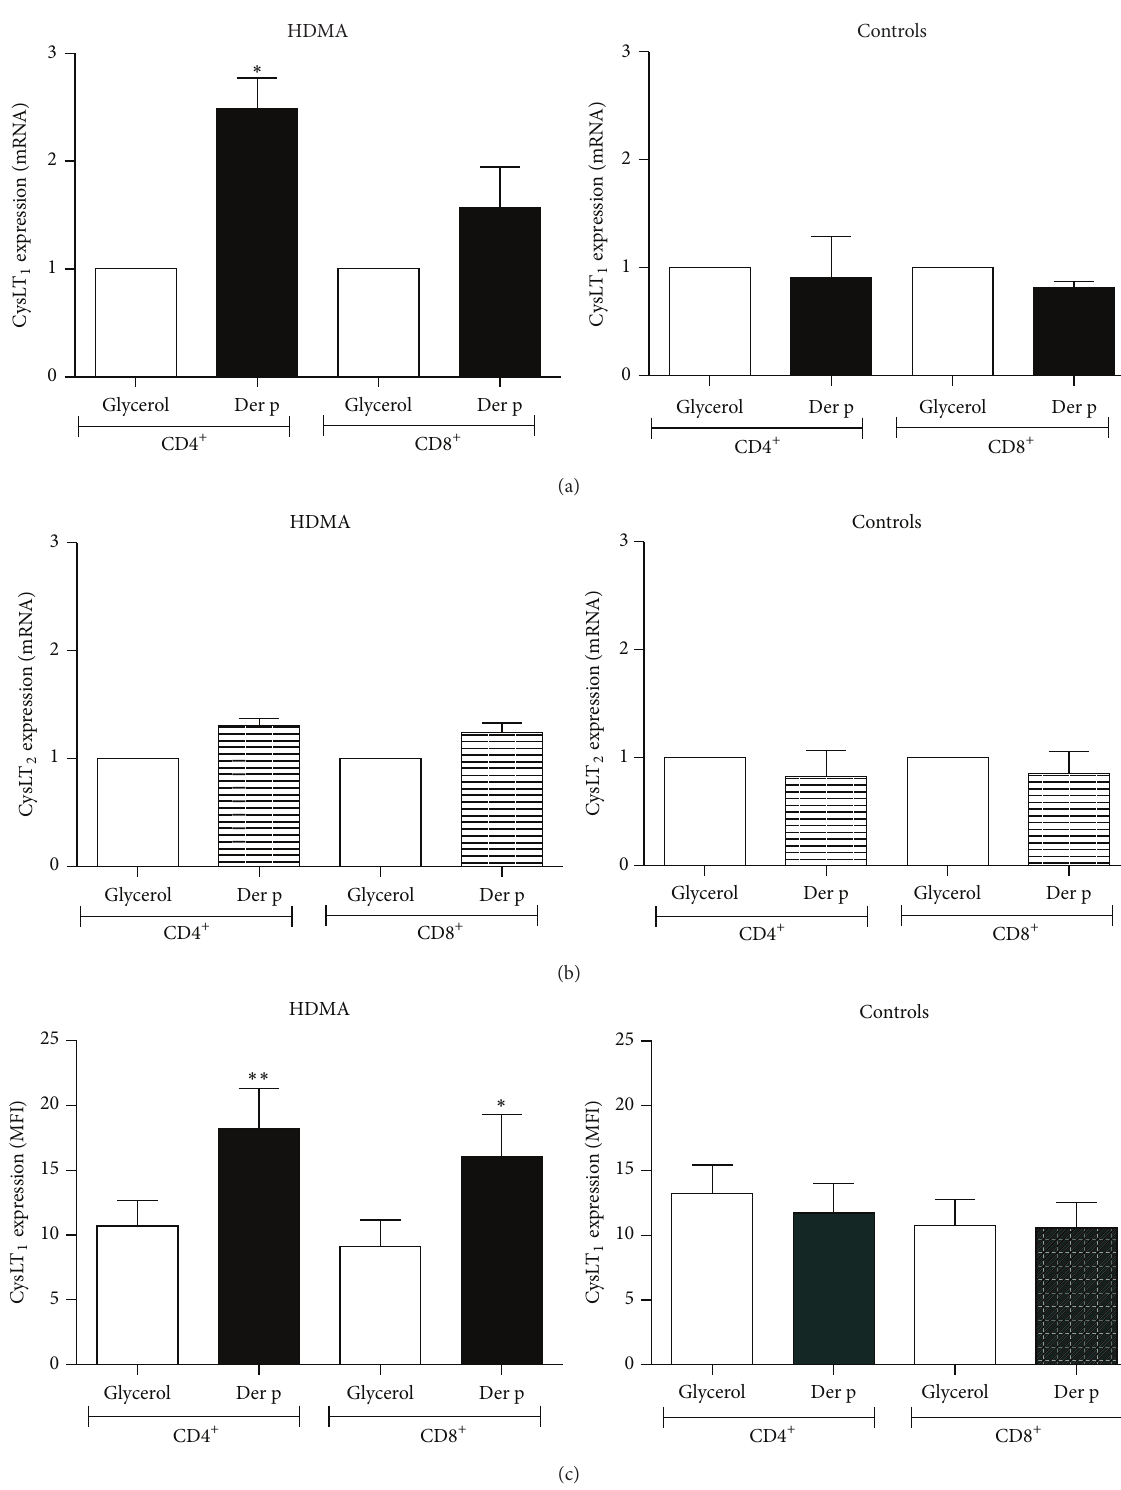
Figure 1: Der p effect on T cell CysLT 1 and CysLT 2 mRNA and protein expression. Comparison of CysLT 1 and CysLT 2 mRNA expression in CD4 + and CD8 + T cells from healthy controls and HDM-allergic (HDMA) patients following stimulation with the Der p allergen (200 AU/mL). PBMC from healthy control and HDMA subjects were cultured for 48 h (qPCR) or 72 h (FACS) in the presence of glycerol vehicle or Der p before CD4 + and CD8 + T cells were purified and collected for analysis. CysLT 1 (a) and CysLT 2 (b) mRNA expression was measured by real-time quantitative PCR analysis. Data are presented as fold ( ΔΔ Ct) increases over GAPDH mRNA ( ± SEM). ∗ 𝑃 < 0.05 and ∗∗ 𝑃 < 0.01 , relative to vehicle glycerol; 𝑛 = 6 for controls; 𝑛 = 10 for HDMA. Cell surface expression of CysLT 1 (c) receptor was evaluated usingrabbitpolyclonalanti-CysLT 1 receptorAb,followedbylabelingwithFITC-conjugatedgoatanti-rabbitIgG.Cellswerefurtherincubated with anti-CD4 PE-Cy5 and anti-CD8 PE Ab before analysis on a FACSCalibur flow cytometer. Data are expressed as geometric mean ( ± SEM) fluorescence intensity (MFI). ∗ 𝑃 < 0.05 ; 𝑛 = 6 for controls; 𝑛 = 10 for